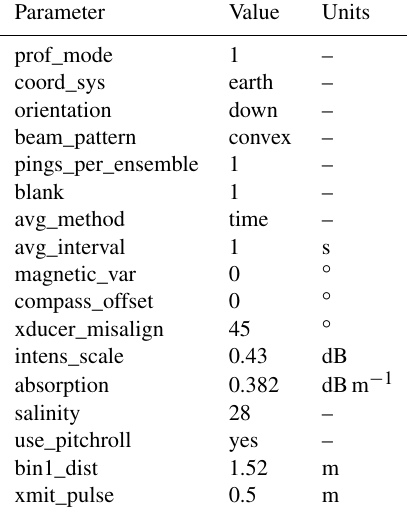
Table 2. Instrument